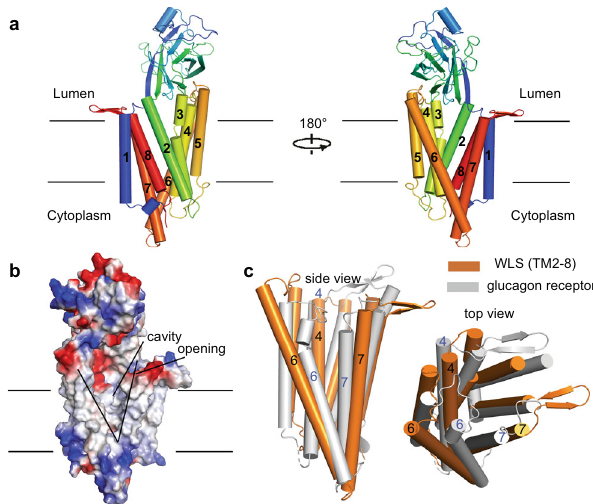
Fig. 2 Structural features of WLS. a Overall structure of WLS. WLS is shown in cartoon with cylindrical helices and rainbow colored. Helix numbers are labeled. b Electrostatic analysis result. The cavity and lateral opening are indicated. c Superimposition of TM2-8 of WLS and TM region of glucagon receptor (PDB code: 5XF1). Both side view and top views are